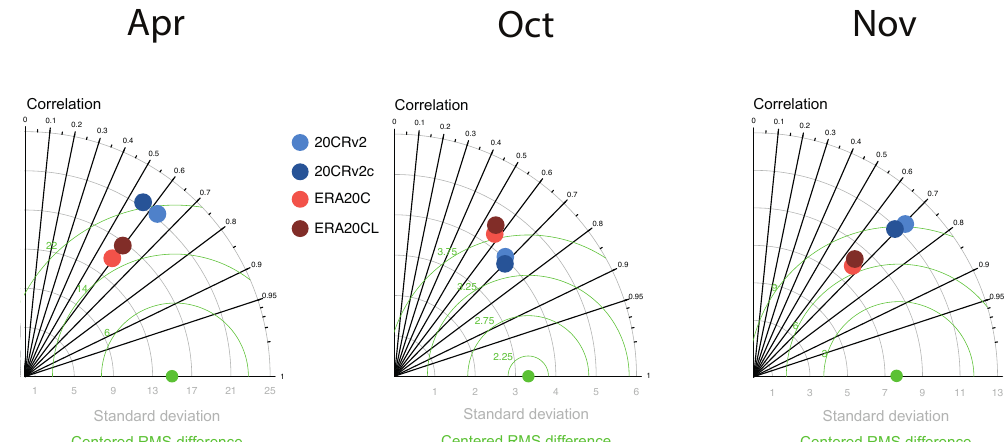
Figure 6. Taylor diagrams showing the median of the 13 station locations using daily data for the longest period available (see Table 1). The x axis and y axis indicate the standard deviation, the radians indicate correlation values and the green circles indicate centered RMSE. The green dot shows the observed variability. For more details concerning the datasets statistics, see Supplement Figs. S3–S6. ERA-20C is labeled as ERA20C, and ERA-20C land is labeled as ERA20CL.